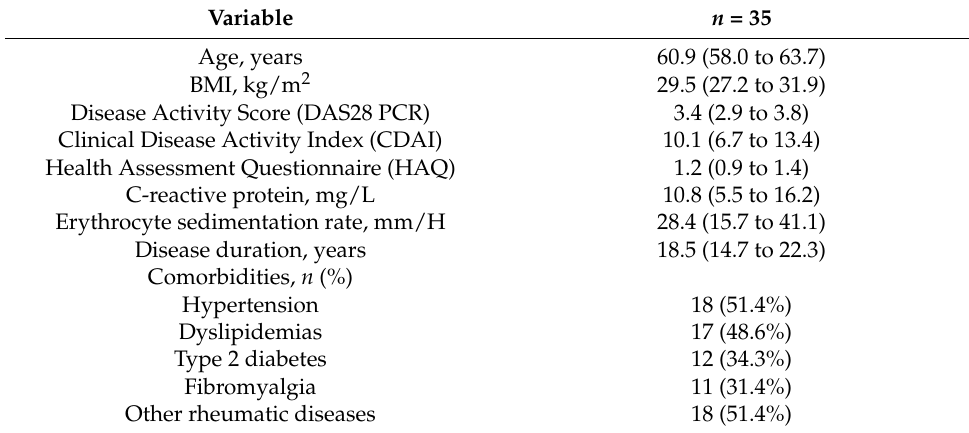
Table 1. Patients’ characteristics prior to the COVID-19